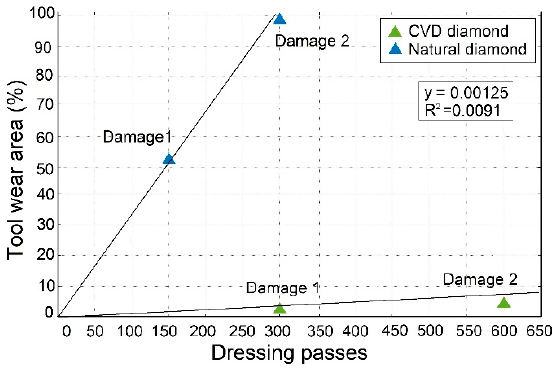
Figure 2. Diamond dressing tools wear analysis.